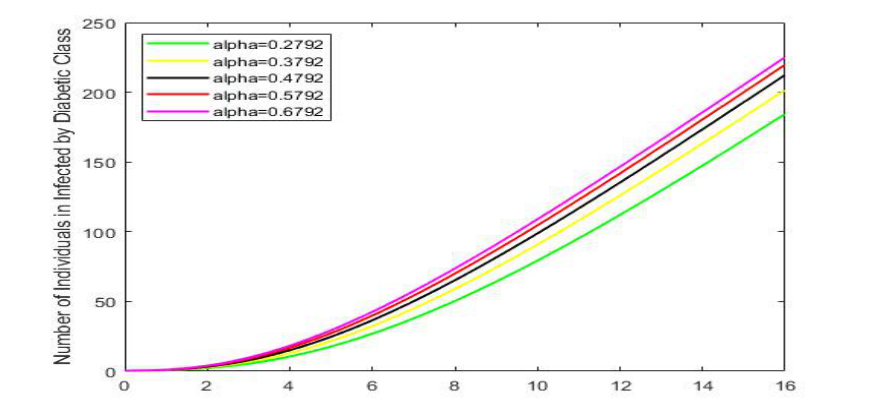
Figure 8: Infected by Diabetic class for different values of α without control pa- rameters